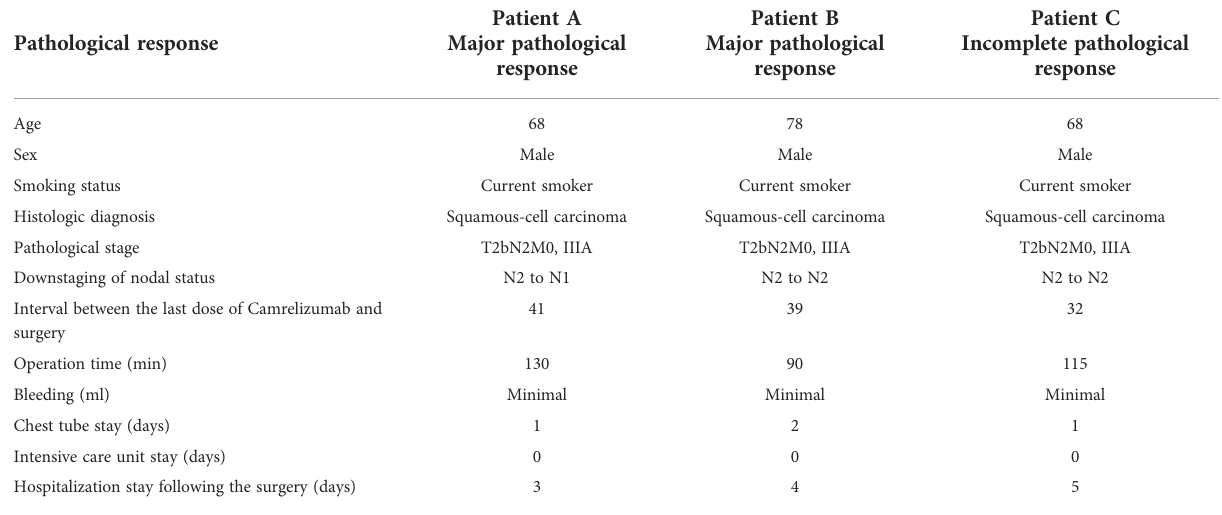
TABLE 1 Characteristics of the three